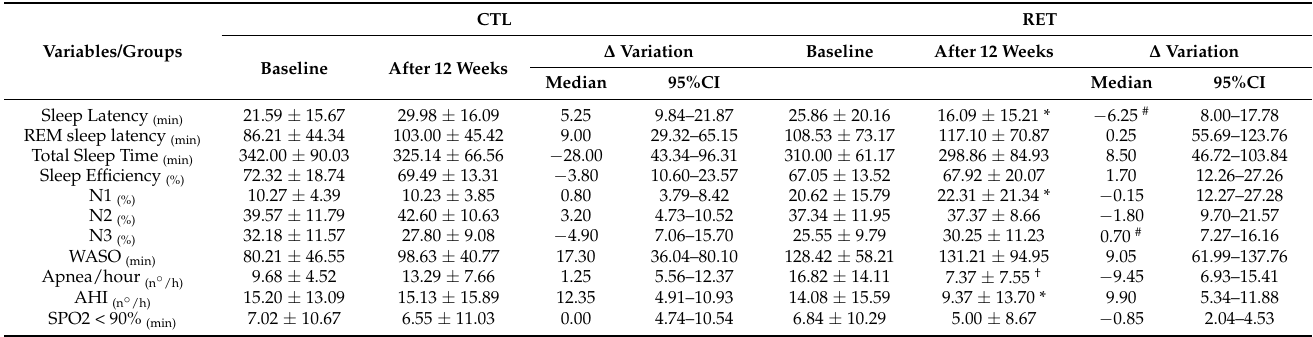
Table 2. Evaluation of sleep aspects through full-night polysomnography.